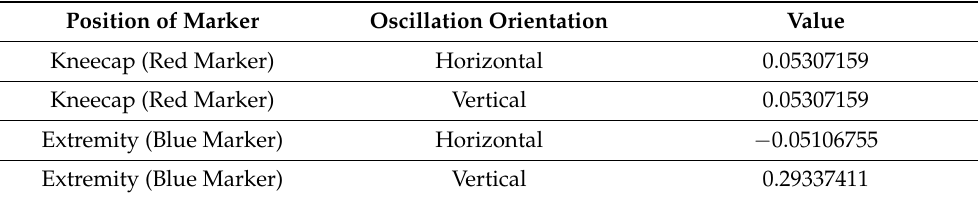
Table 2. Pearson correlation values between the markers and the kneecap to extremity distance with the probe in lifting operation.